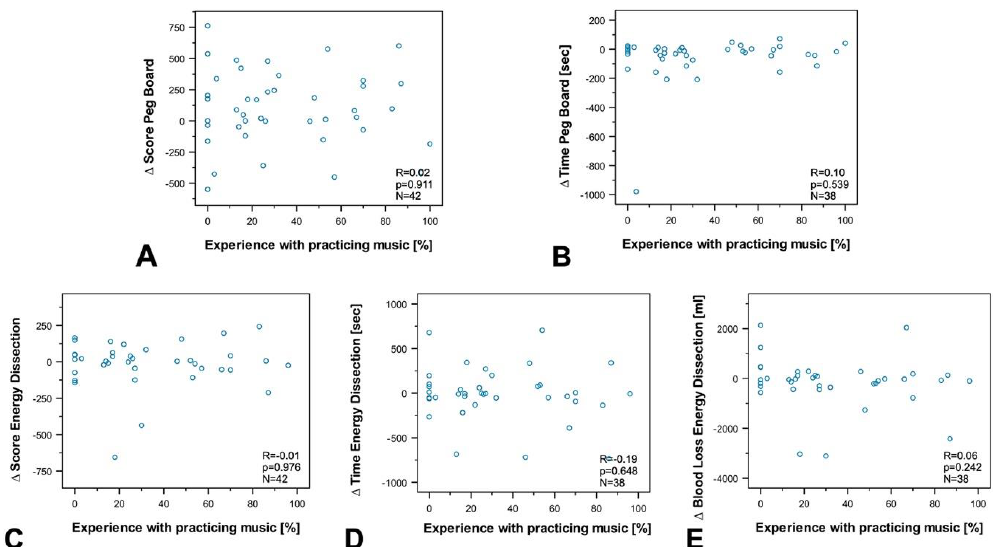
Figure 7. Correlation analysis between experience in practicing music, and ( A ) ∆ Final Score in Peg Board, ( B ) ∆ Time to complete Peg Board, ( C ) Final Score Energy Dissection, ( D ) ∆ Time to complete Energy Dissection, and ( E ) ∆ Blood Loss Energy Dissection. No significant correlation was found for any of the values (correlation coefficient: R, statistical significance: p, number: N).